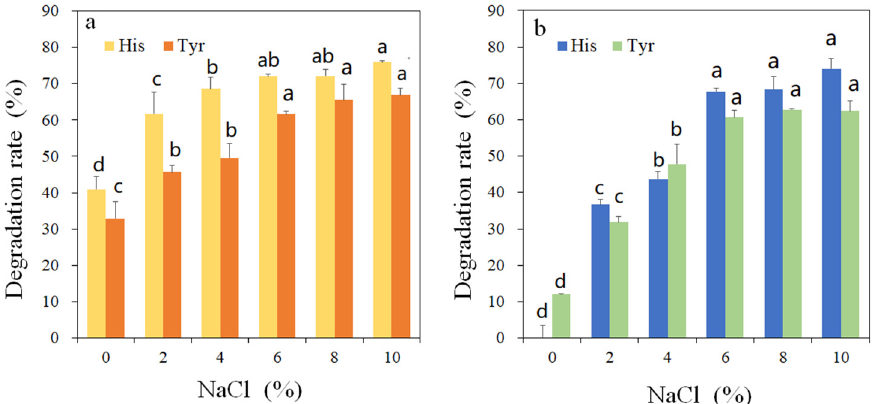
Figure 7. Effect of NaCl on the activity of rMCO towards histamine and tyramin. ( a ) pH = 7 and ( b ) pH = 4. Different letters indicate significantly different ( p < 0.05) mean values.